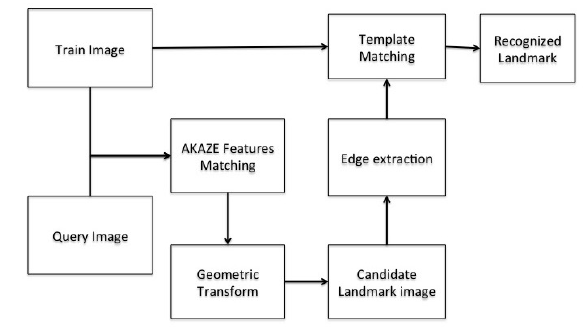
Figure 2. Proposed landmark recognition scheme same size as the train image. If it were a true positive recog- nition, both images would be the same and a false positive en- counter would produce a different image. In order to evaluate it, a template matching method was used. So the edges of both the candidate and the train image were extracted, resulting in two bi- nary images. Those images would be used to compute the classic correlation coefficient using equation 1, where T is the train edge image and I is the candidate edge image. In case the correlation coefficient is higher than a threshold, the landmark is finally rec- ognized. Figure 2 show each step for